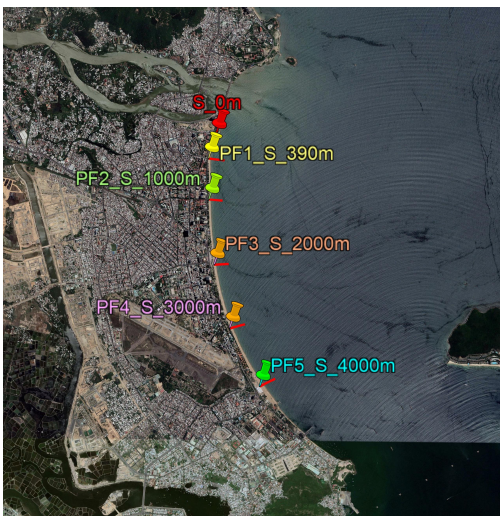
Figure 8. The five profile transects of interest. S_0m is considered the landmark